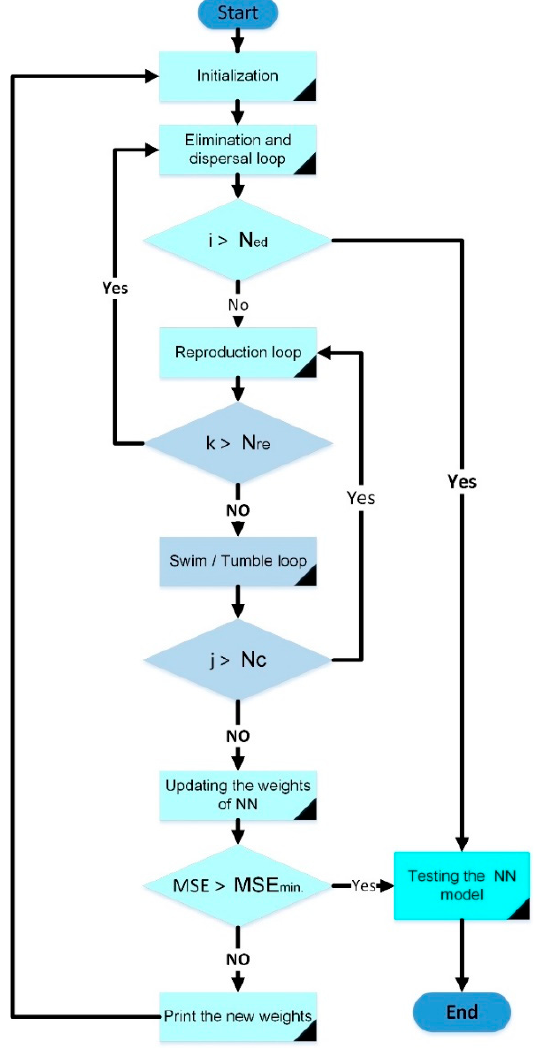
Figure 8. Flowchart of a BF-NN algorithm.